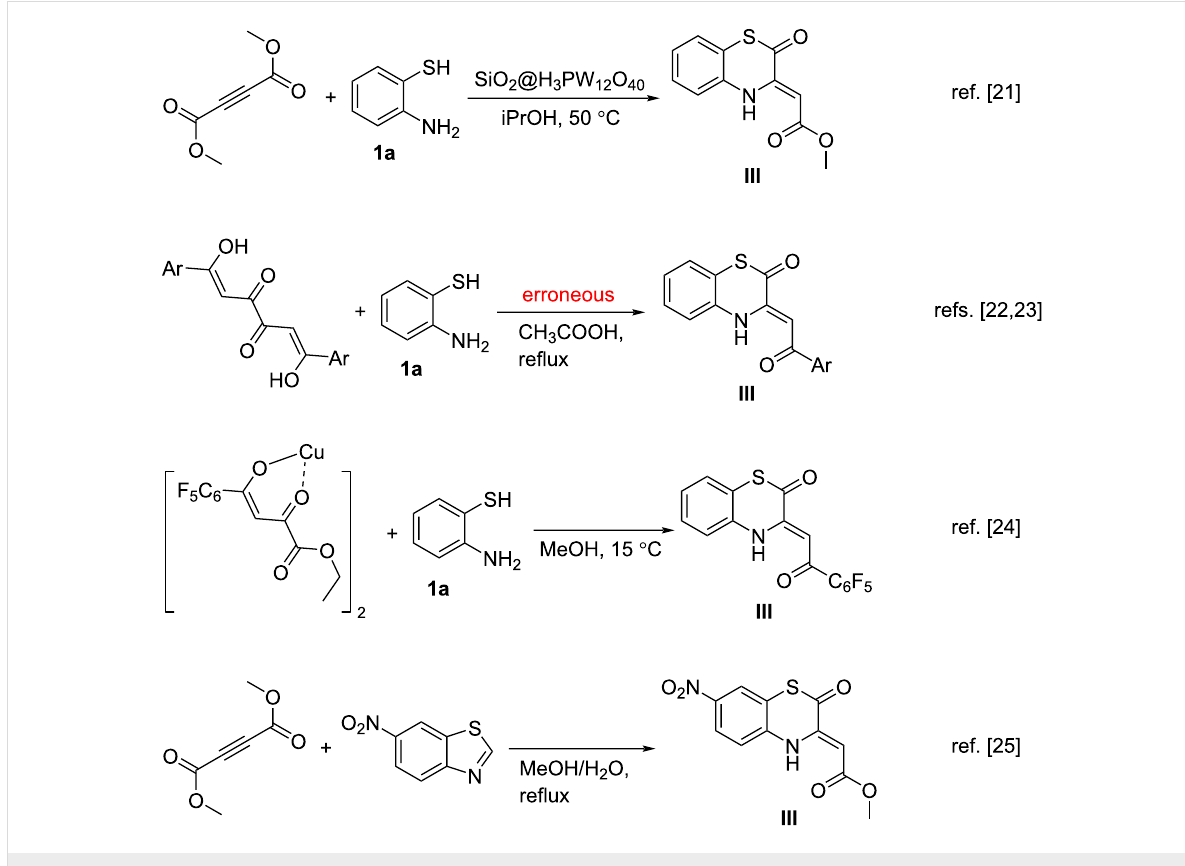
Scheme 2: Known synthetic approaches to BTAs III .